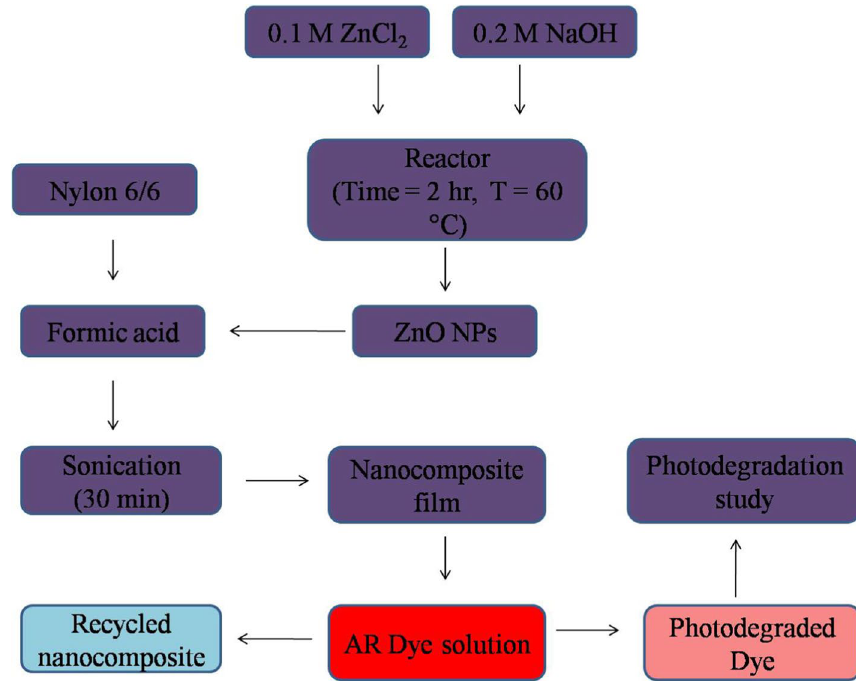
Fig. 1 Schematic diagram of nanocomposite preparation and AR dye degradation